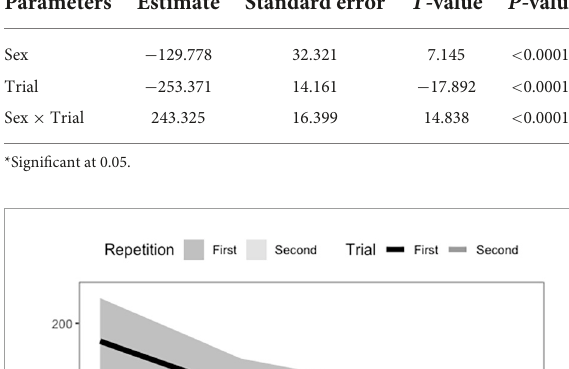
TABLE 3 Parameter estimated for the linear mixed model estimating the effect of sex, trial and the interaction between trial and vocal sex, on the time spent finding the roost by vocal